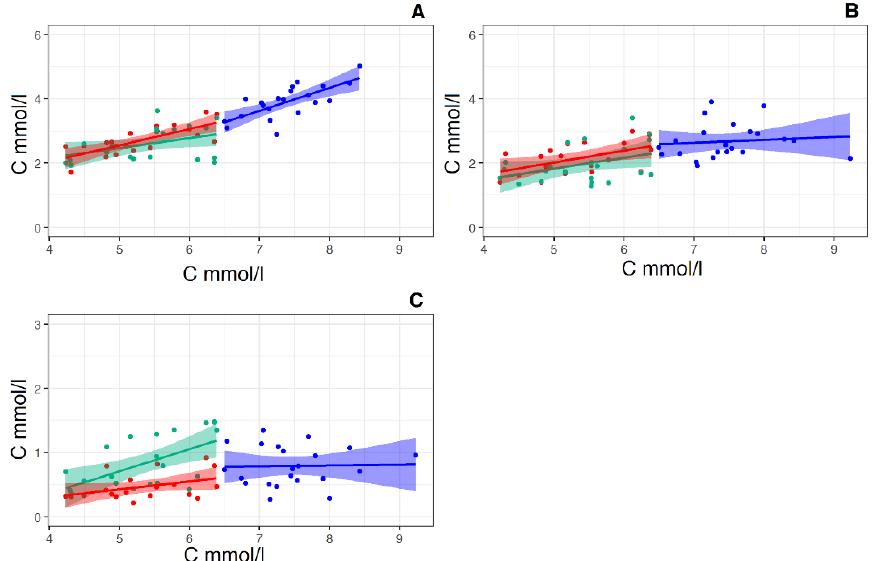
Figure 7. Linear regression of the pairs “total cholesterol concentration ( X -axis)—calculated LDL-C concentration ( Y -axis)” ( A ), “total cholesterol concentration ( X -axis)—HDL-C concentration ( Y -axis) pairs” ( B ) and the pairs “total cholesterol concentration ( X -axis)—calculated VLDL-C concentration ( Y -axis)” ( C ), ( X -axis and Y -axis in mmol/L) in the control group (Red straight, N = 19) and in the groups “Before therapy” (Blue straight N = 22) and “After therapy” (Green straight N = 22). For pear “total cholesterol concentration—calculated LDL-C concentration” for the control group linear regression equitation: y = 0.51x + 0.02, R2 = 0.53, p < 0.001. For the group “Before therapy” linear regression equitation: y = 0.71x—1.36, R2 = 0.49, p < 0.001. For group “After therapy” linear regression equitation: y = 0.31x + 0.9, R2 = 0.13, p < 0.05. For pear “total cholesterol concentration—calculated HDL-C concentration for the control group linear regression equitation: y = 0.37x + 0.18, R2 =